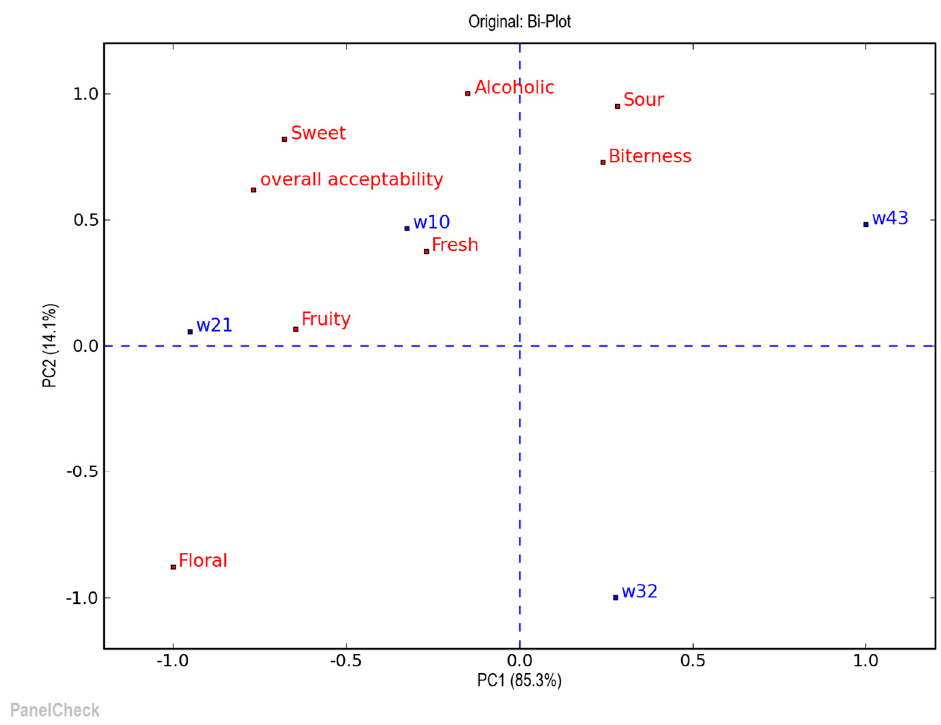
Figure 4. Wine sensory attributes presented by graph of principal component analysis (PCA). The research wine samples were prepared by the proposed technology of freeze-dried raw materials without prior storage (W10) and after storage for 30 (W21), 60 (W32) and 90 (W43) days, respectively.